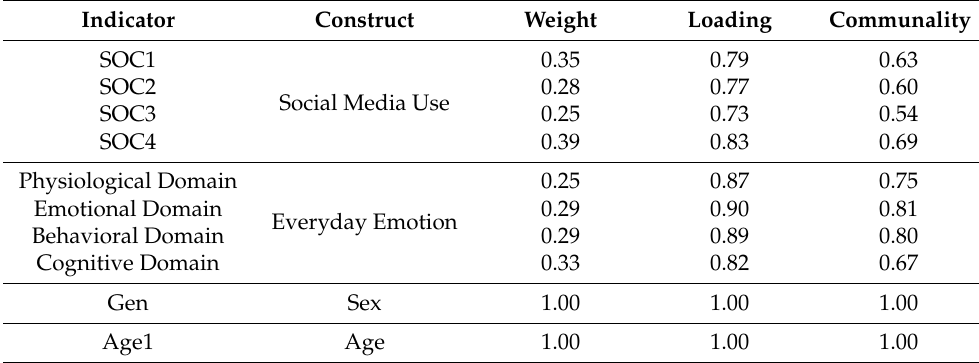
Table 6. Outer model summary table for the PLS-PM model.